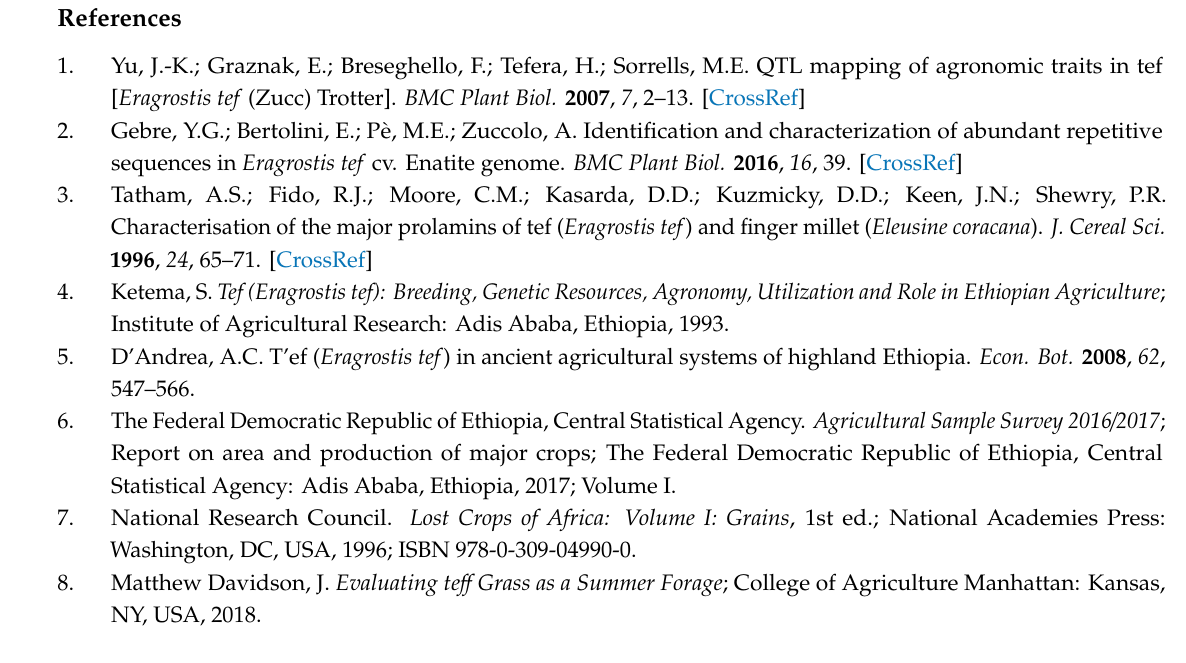
Table S1: E ff ects of genotypes and sowing rates on ground-based lodging index (LI) and remotely-sensed indices; mean pixel height (RSmean), modal pixel height (RSmode), maximum pixel height (RSmax), and culm length (CL) measured at early flowering (7–8 weeks after emergence) and late flowering (10 weeks after emergence) during the 2019